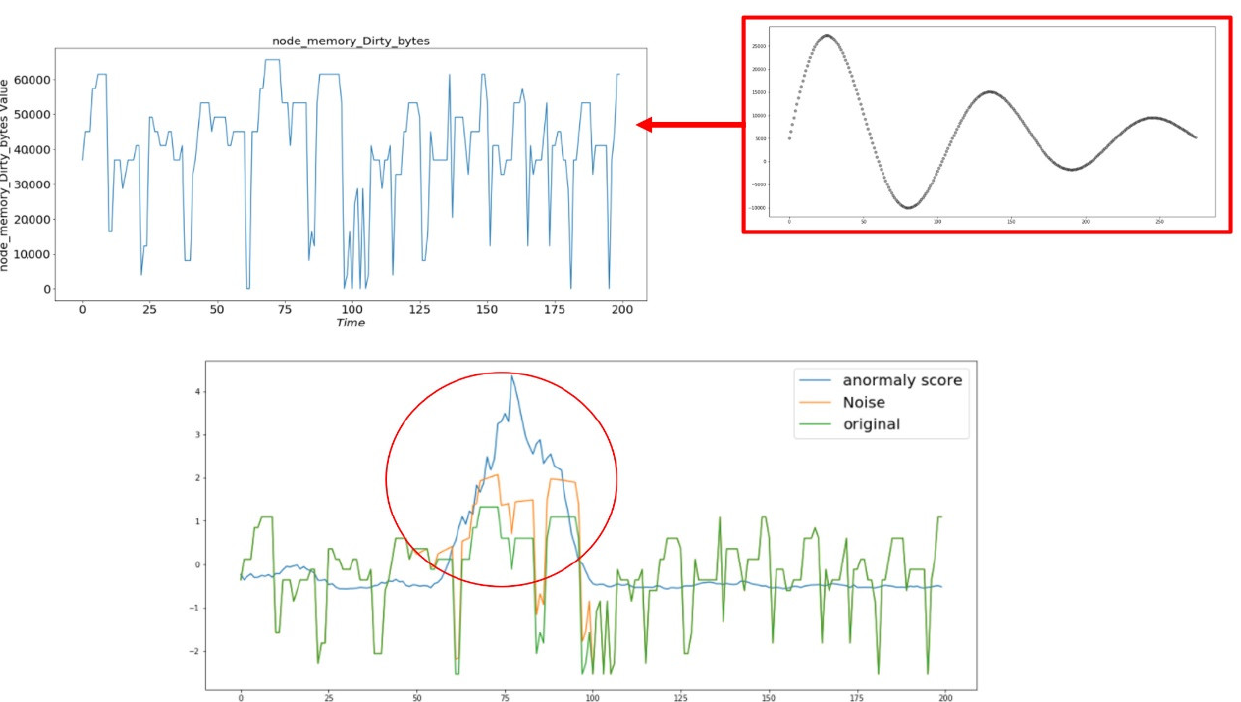
Figure 11. Anomaly Score (Virtual noise Fault).